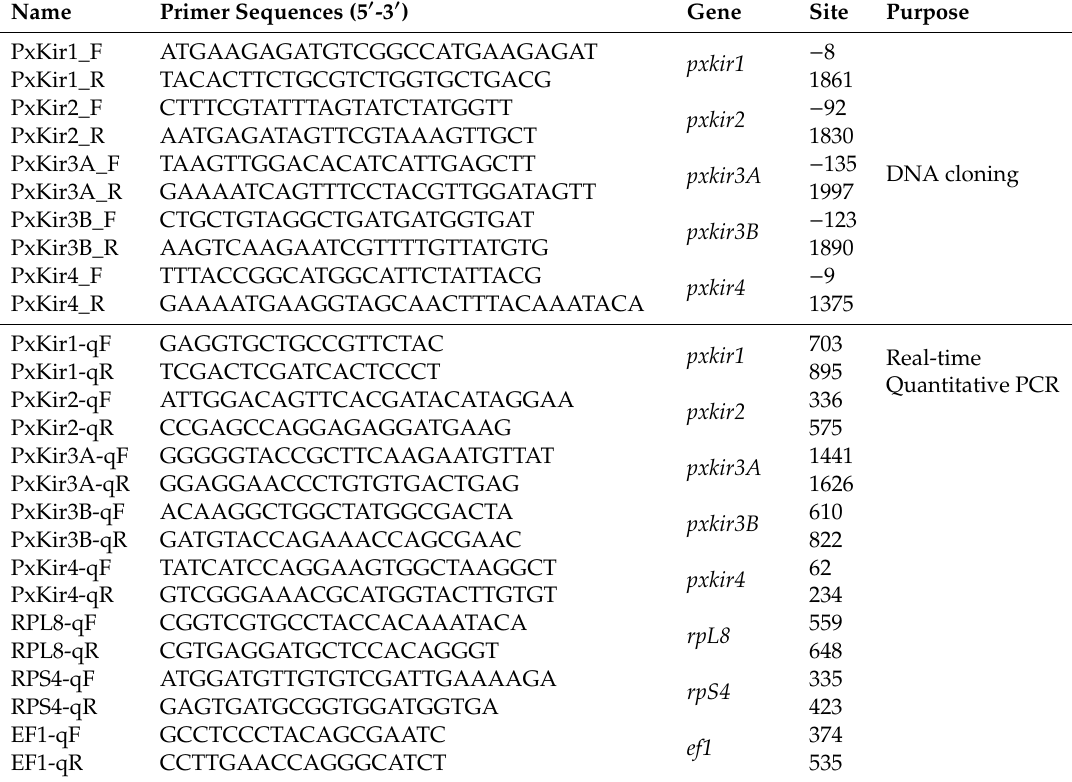
Table 1. Primers used for clone and expression analysis of genes in Plutella xylostella .